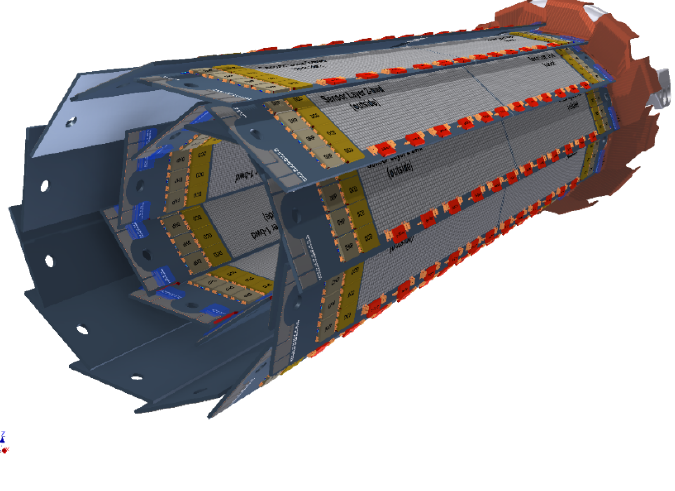
Figure 1: The Belle II Pixel Vertex Detector